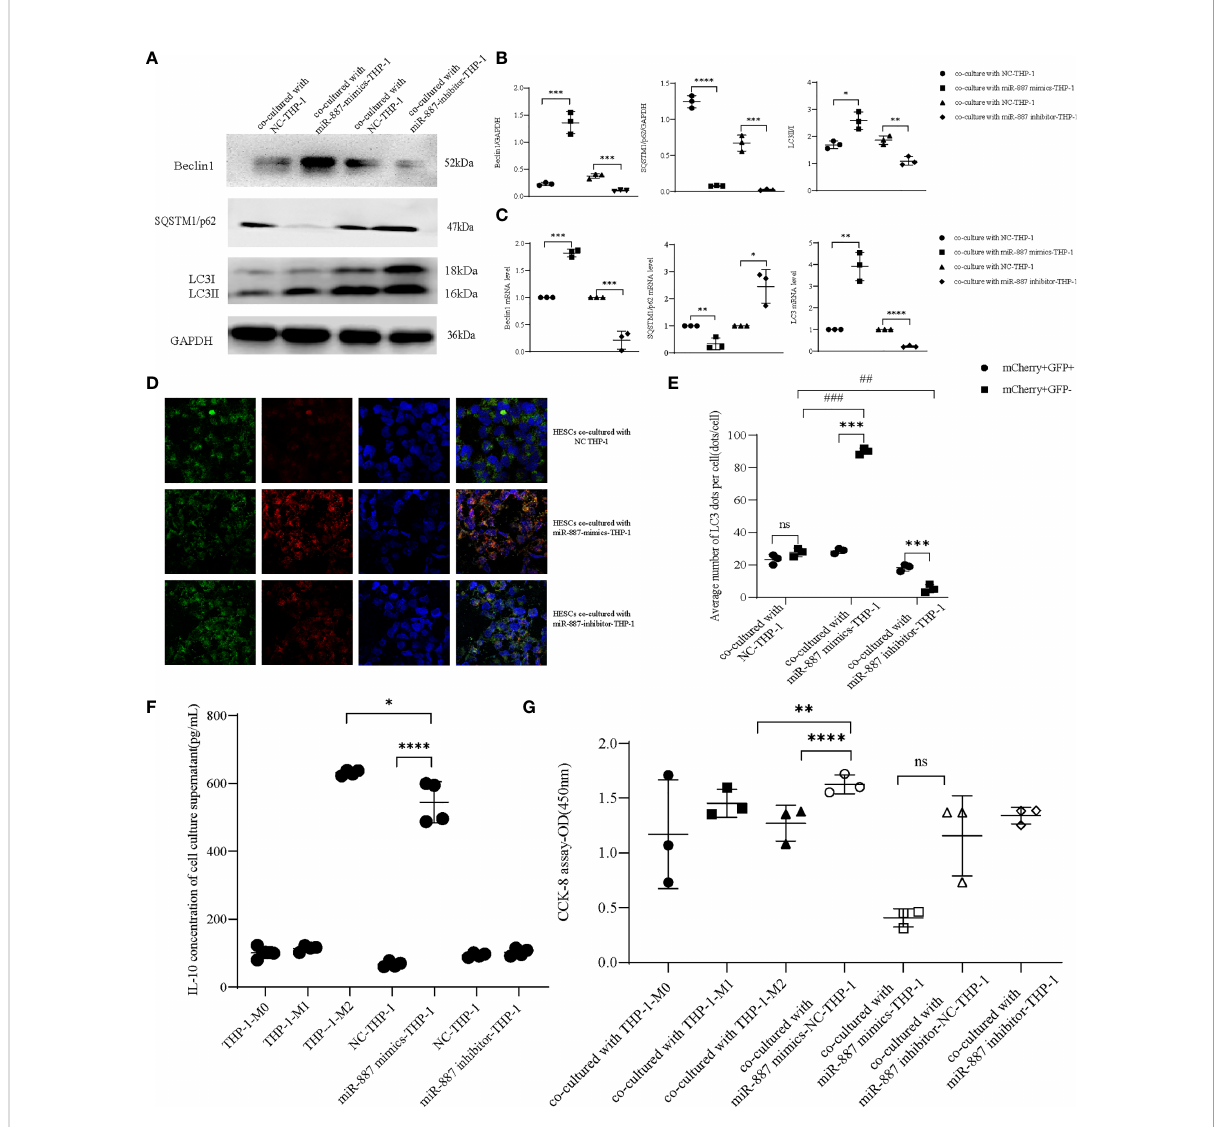
FIGURE 6 miR-887-5p inhibits the expression of MST1 in THP-1 cells and activates autophagy in HESCs. (A, B) HESCs co-cultured with miR-887-5p- mimics and/or -inhibitor-THP-1, the protein expression of autophagic genes by western blot. (C) The mRNA level of autophagic genes in co- cultured HESCs by RT-PCR. (D, E) HESCs co-cultured with miR-887-5p-mimics and/or -inhibitor-THP-1, then were transduced with mCherry- GFP- LC3 adenovirus. At least 10 – 20 cells per condition were imaged using a confocal microscope. (F) The IL-10 concentration of the culture supernatant after transfection of miR-887-5p-mimics and -inhibitor in THP-1 (G) The cell viability of co-cultured HESCs. *P < 0.05, **P < 0.01, ***P < 0.001, ****P < 0.0001, ## P < 0.01, ### P < 0.001, ns means not statistically signi fi cant. Values represent the mean ± standard